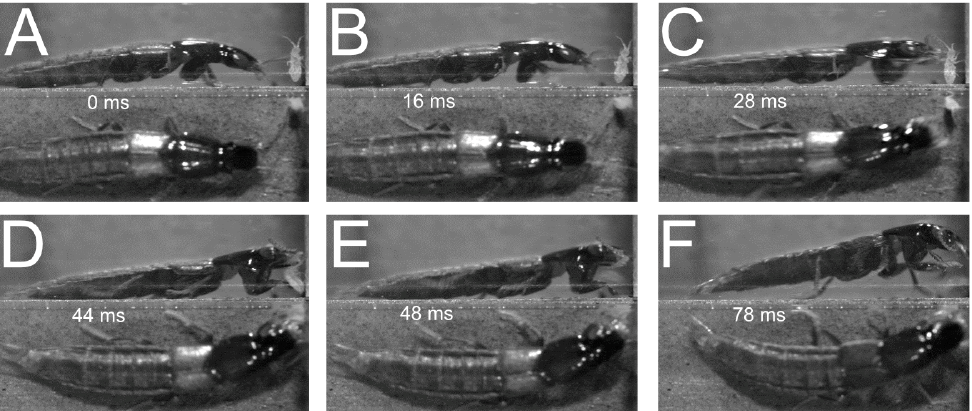
Figure 19. Quedius curtipennis . Overwhelming of a Heteromurus nitidus springtail by using the front pair of legs in the initial attack. In the last image of the sequence, the initiation of caging behaviour is visible after the springtail escaped the initial attack (upper parts: side view; lower parts: top view). Time course of depicted sequence is provided in milliseconds elapsed from the start (= image A ). Images B – F depicting the process of prey capture. For further description, see text.